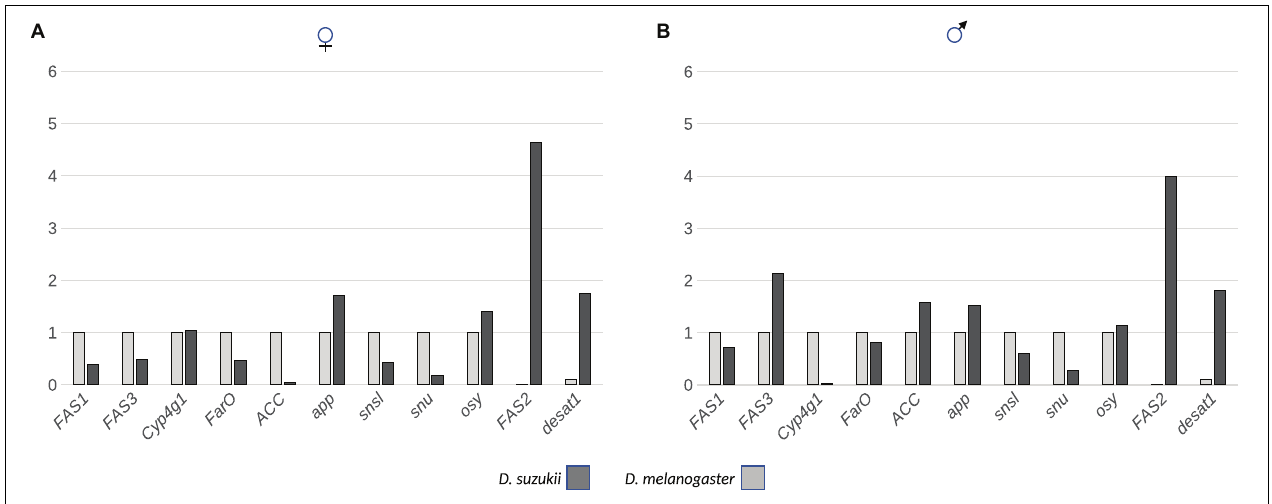
FIGURE 5 | The expression of genes coding for enzymes and proteins involved in lipid (CHC) biosynthesis and transport was monitored by qPCR in females (A) and males (B) of D. suzukii and D. melanogaster . For all transcripts except for FAS2 and desat1 , the D. melanogaster expression levels were set to 1. For FAS2, the expression level of the D. melanogaster transcript was set to 0.01, and the expression level of the D. melanogaster desat1 transcript was set to 0.1. The p -values following a Student’s t -test are 0.04 (female; f) and 0.33 (male; m) for FAS1 , 0.29 (f) and 0.004 (m) for FAS3 , 0.88 (f) and 0.004 (m) for Cyp4G1 , 0.05 (f) and 0.048 (m) for FarO , 0.007 (f) and 0.04 (m) for ACC , 0.002 (f) and 0.046 (m) for app , 0.098 (f) and 0.49 (m) for snsl , 0.03 (f) and 0.003 (m) for snu , 0.047 (f) and 0.006 (m) for osy , 0.02 (f) and 0.0007 (m) for FAS2 and 0.009 (f) and 0.009 (m) for desat1 expression